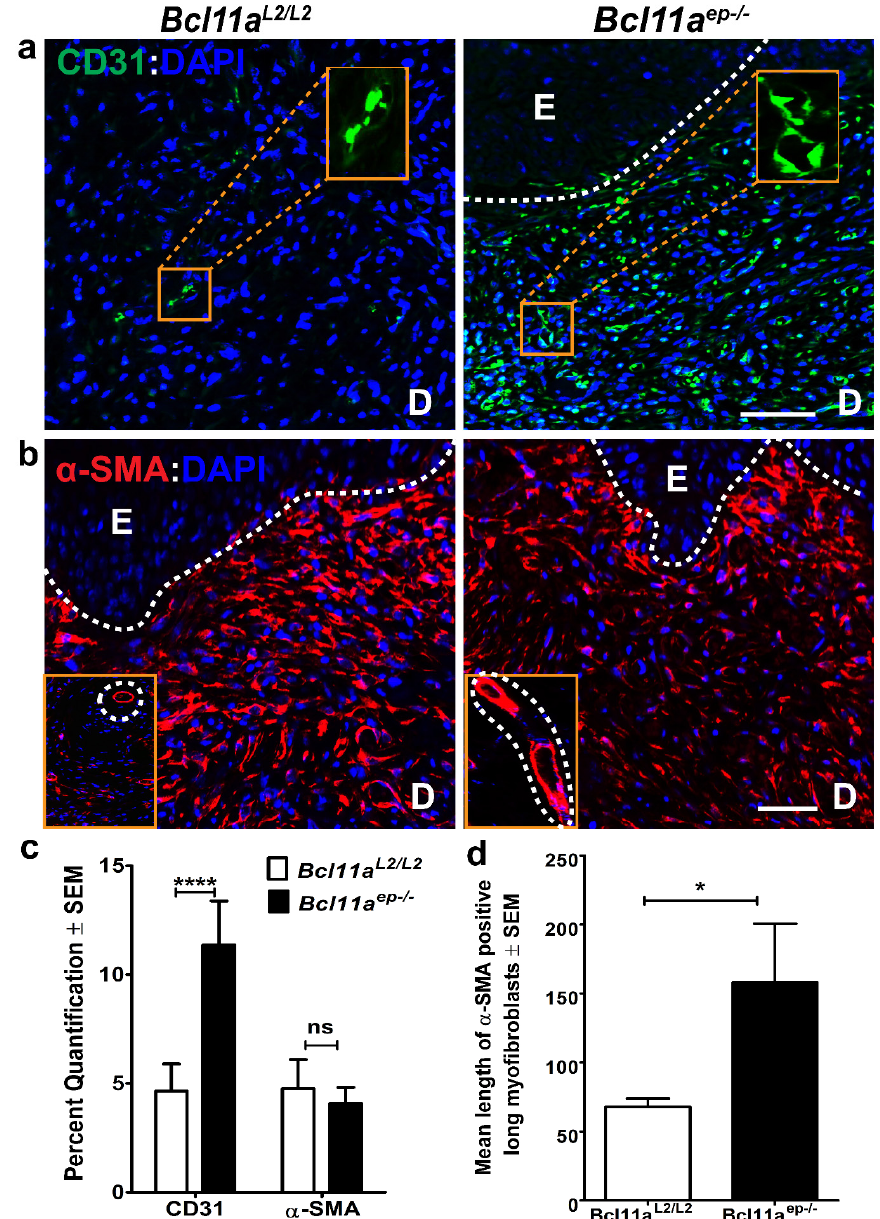
Figure 6. Non-cell autonomous role of epidermal Bcl11a deletion in facilitating healing through advanced angiogenesis and myofibroblast maturation (Day 8). ( a , b ) IHC analysis of endothelial cell marker CD31 (green) and myofibroblast marker α -SMA (red) expression in WBD on Day 8 post wounding samples from Bcl11a L2/L2 versus Bcl11a ep − / − mice. All sections were counterstained with DAPI (blue). White dotted lines separate E from D and outline the HFs. The insets respectively show magnified version of blood vessels formed by endothelial cells ( a ) and mature myofibroblasts ( b ). D—Dermis; E—Epidermis; HF—Hair follicle; WBD-Wound Bed Dermis. Scale bar = 100 µ m. ( c ) Bar graph quantification displaying the Day 8 post wounding expression status of dermal markers (CD31 and α -SMA) in Bcl11a L2/L2 versus Bcl11a ep − / − mice. ( d ) Bar graph quantification highlighting the difference in the mean length (in µ m) of mature myofibroblasts in the Day 8 wound bed of Bcl11a L2/L2 versus Bcl11a ep − / − mice. N = 4, where N represents the number of animals of each genotype ( Bcl11a L2/L2 or Bcl11a ep − / − ) being involved in the study. Multiple fields of views (FOVs) captured per sample per genotype to determine the statistical significance. **** p < 0.0001, * p < 0.1, ns <